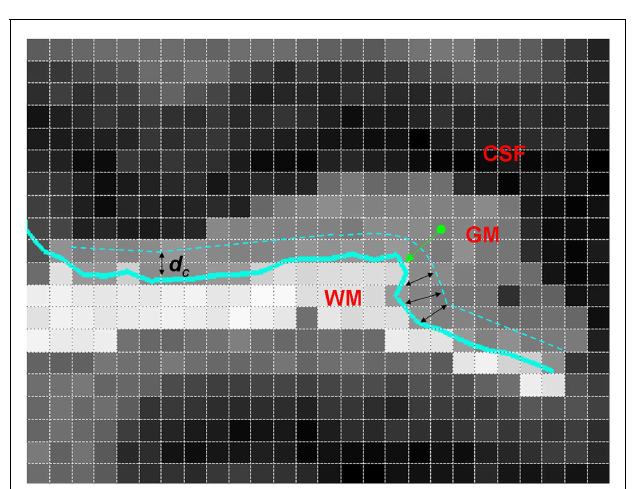
FIGURE 1 |A two-dimensional illustration of LCDM distance computation (i.e., the normal distance) from a GM voxel to the GM/WM PT surface (thick green arrow) . Also shown is the censoring procedure with censoring distance d c (black double arrows). At this censoring step, the GM voxels with centroid closer to the GM/WM surface than d c are